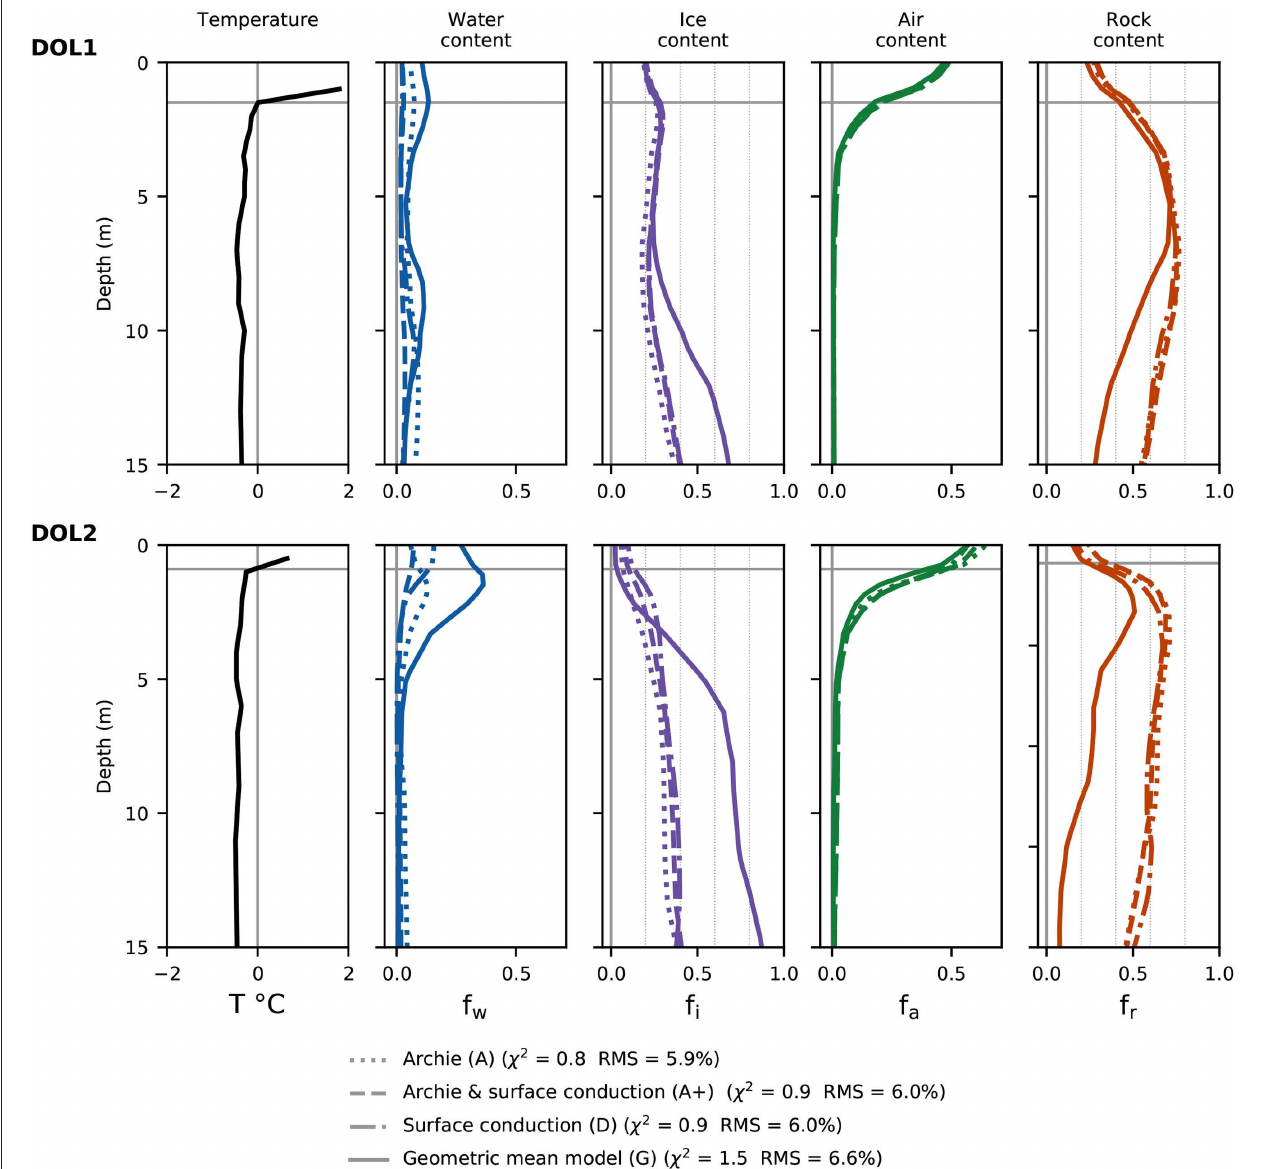
FIGURE 8 | Borehole temperature measured in boreholes DOL1 and DOL2 and corresponding four-phase constituents estimated by the joint inversion with different petrophysical models A, A+, D, and G for the Doldenstock profile. 0 ◦ C temperature lines and thaw depths are marked by gray